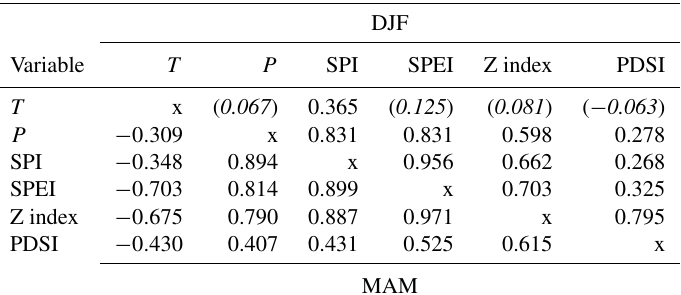
Table 2. Pearson correlation coefficients between seasonal series of temperature ( T ), precipitation ( P ), and drought indices (SPI, SPEI, Z index, PDSI) in the Czech Lands during the 1501–2020 period (coefficients expressed in italics in brackets are statistically non-significant at the 0.05 significance level; all other coefficients are statistically significant).